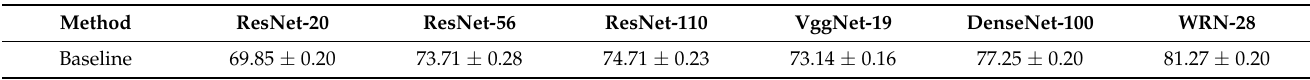
Figure 4. Comparison of the validation accuracy curves and training loss curves of ResNet-110 on CIFAR100. The performance of the training networks with FocusedDropout and random Magnify Weight Decay (MWD) are worse than the baseline before epoch 150, but when the learning rate decays, the networks’ performance is much better than the original model. Table 2. Test accuracy (%) on CIFAR100 dataset. All settings are the same as on CIFAR10. We report the average over 3